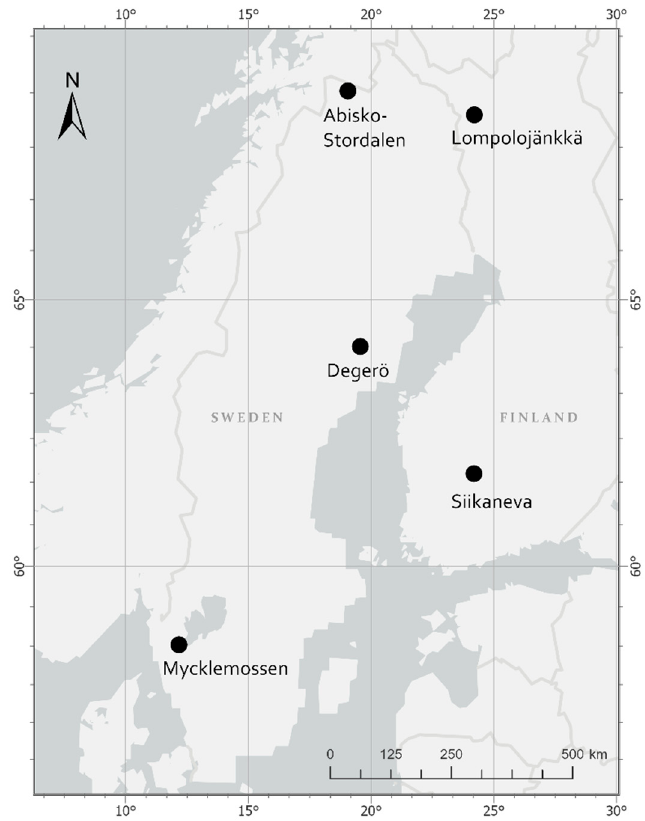
Figure 1. Locations of the peatland EC flux measurement sites.